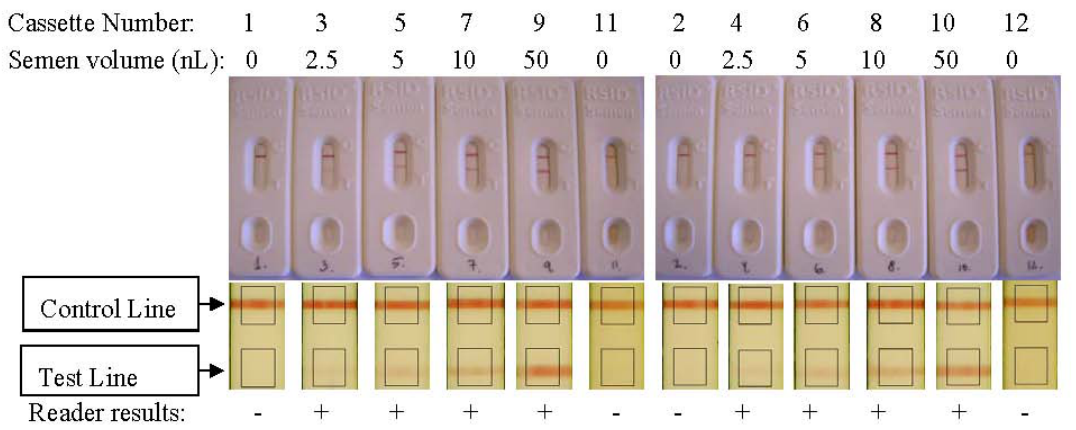
Figure 4. Results of RSID™ Semen and RSID™ Reader Experiments. Results of two replicates for each analyzed semen volume from one Reader are shown. Cassette number and calculated volume of semen added to each cassette are shown ( top ). Digital camera capture of cassettes and RSID™ Reader images are shown below,